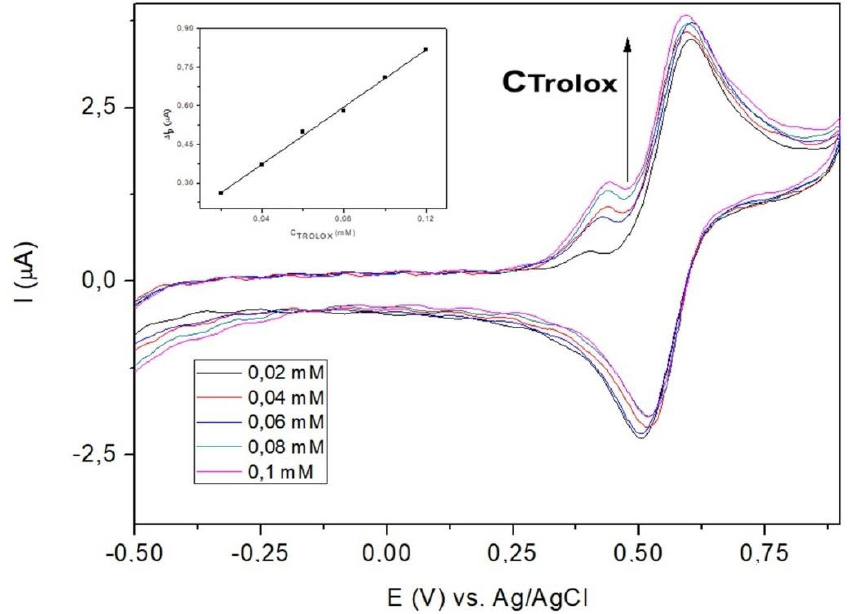
Figure 19. Changes in CVs features of ABTS · + solution in the presence of increased concentrations of Trolox (scan rate 50 mV/s). Inset: calibration plot for the TEAC electrochemical assay obtained from the CVs of ABTS · + in the presence of increasing concentration of Trolox.